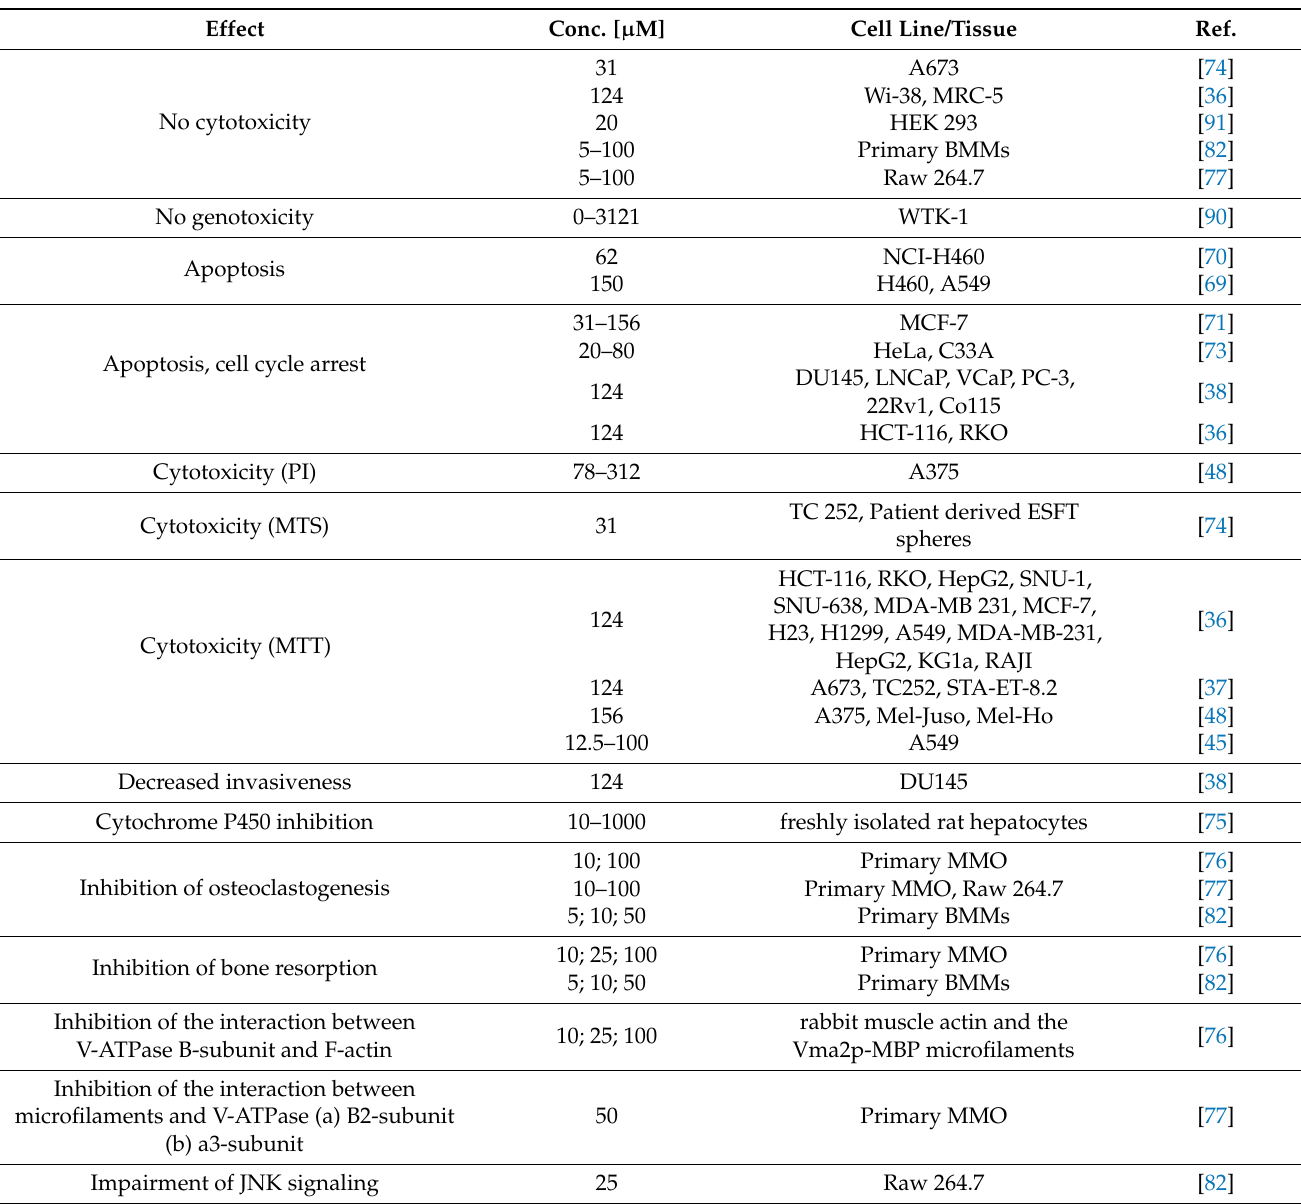
Table 3. Cytotoxic effects of enoxacin depending on the concentration in various cancer cell lines and animal